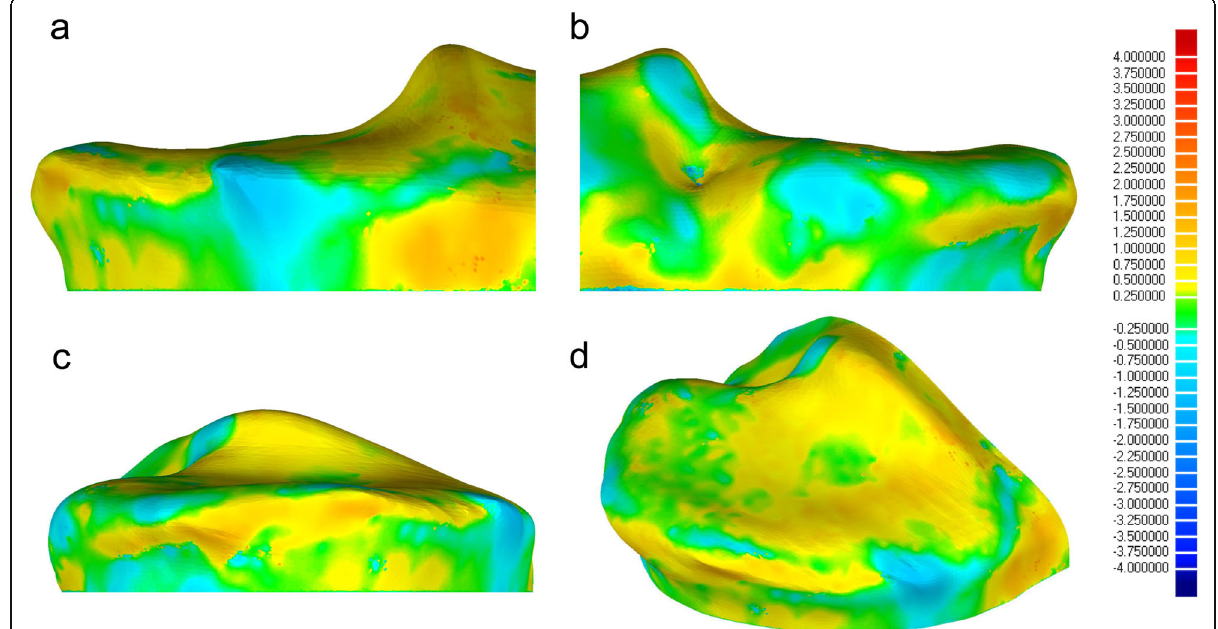
Fig. 7 Representative case showing surface differences on medial tibial plateau models. a anterior view. b . Posterior view. c Medial view. d View from the